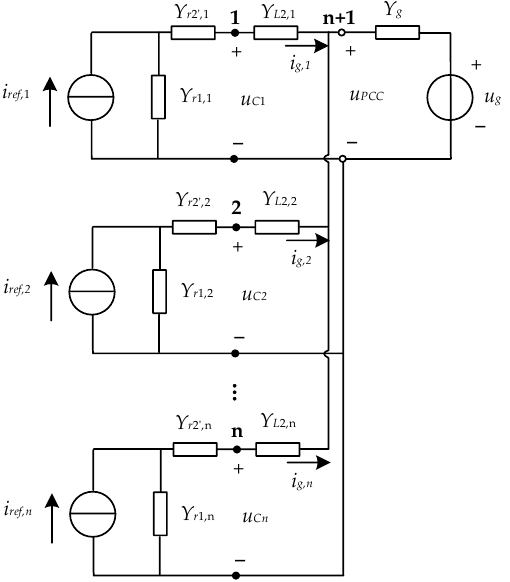
Figure 7. The equivalent model of a multi-inverter grid-connected system. The nodes are set in sequence for n inverters, which are numbered, and PCC is num- bered n + 1 in Figure 7. The node derivative matrix of the system satisfies the following node voltage equation, as shown in Equation (17).